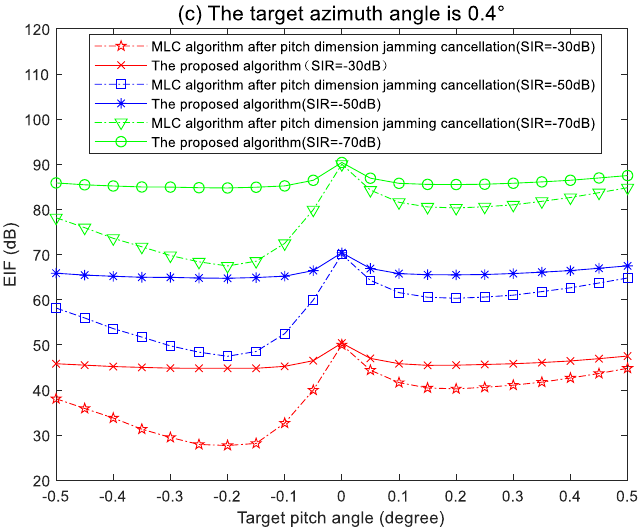
Figure 5. The EIFs of the two algorithms.